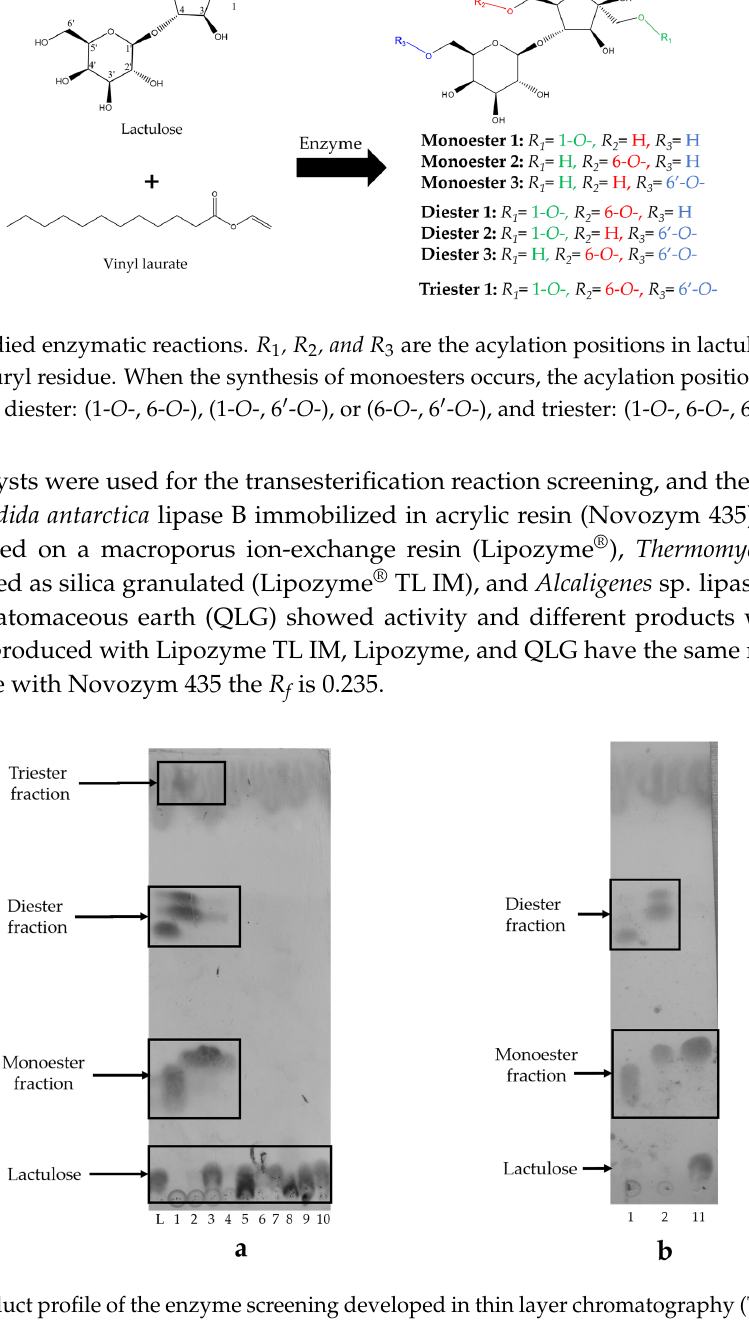
Figure 3. Product profile of the enzyme screening developed in thin layer chromatography (TLC) plates. Reaction conditions: biocatalyst (25 mg/mL), lactulose (30 mM), vinyl laurate (150 mM), T = 60 ◦ C, t = 24 h, solvent: 20% DMF in 2-methyl-2-butanol (2M–2B). ( a ) Lines: (L) Lactulose, (1) Novozym 435, (2) Lipozyme TL IM, (3) Lipozyme from Mucor miehei 20% DMF, (4) Lipozyme from Mucor miehei 0% DMF, (5) Lipase from Rhizopus orizae (Lewatit 160), (6) Lipase from Rhizopus oryzae